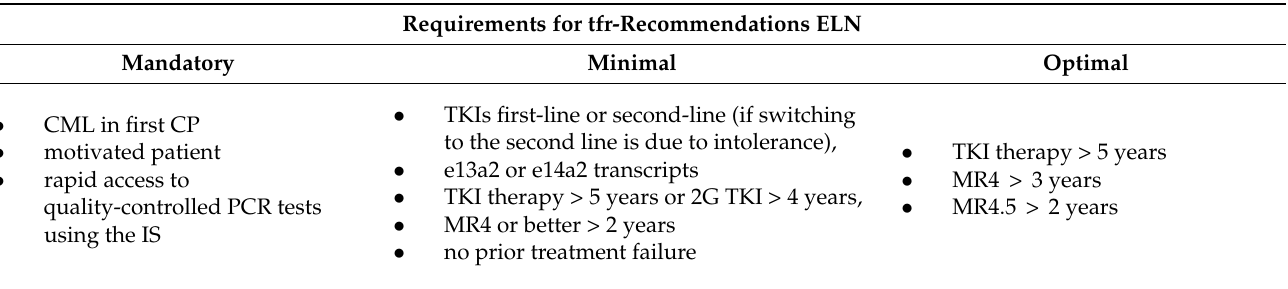
Table 4. Requirements for tyrosine kinase inhibitor